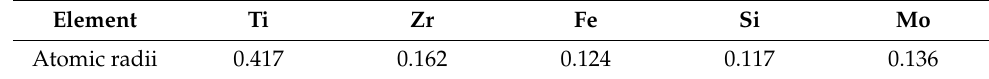
Table 1. Atomic radius of the